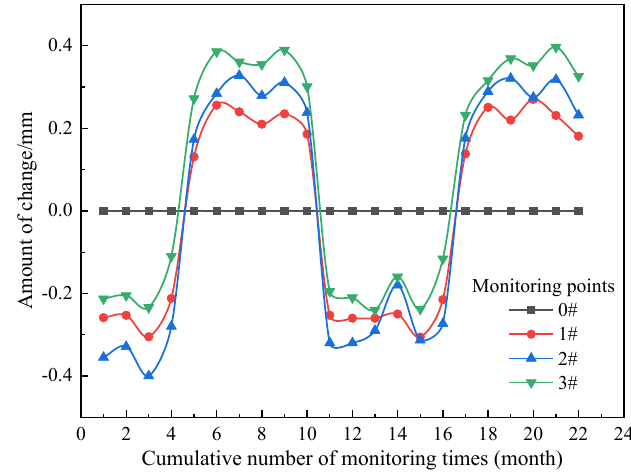
Figure 22. Curve of water level change in foundation pit.